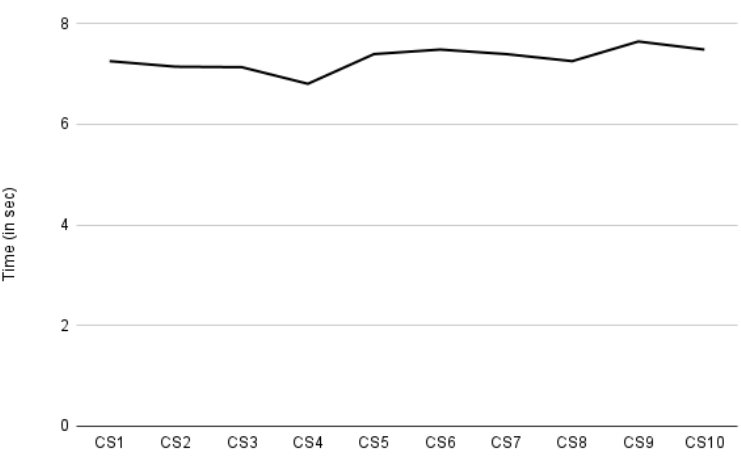
Figure 16. Time spent on consent